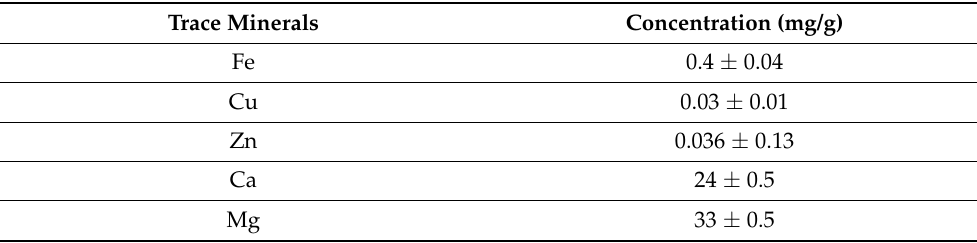
Table 2. Elemental composition of J. rubens by atomic absorption spectroscopy. Trace Minerals